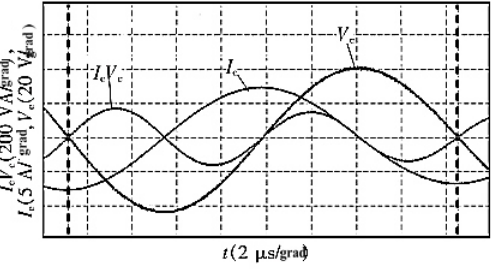
Fig. 5. Circuit topology of a basic step-down resonant switched capacitor